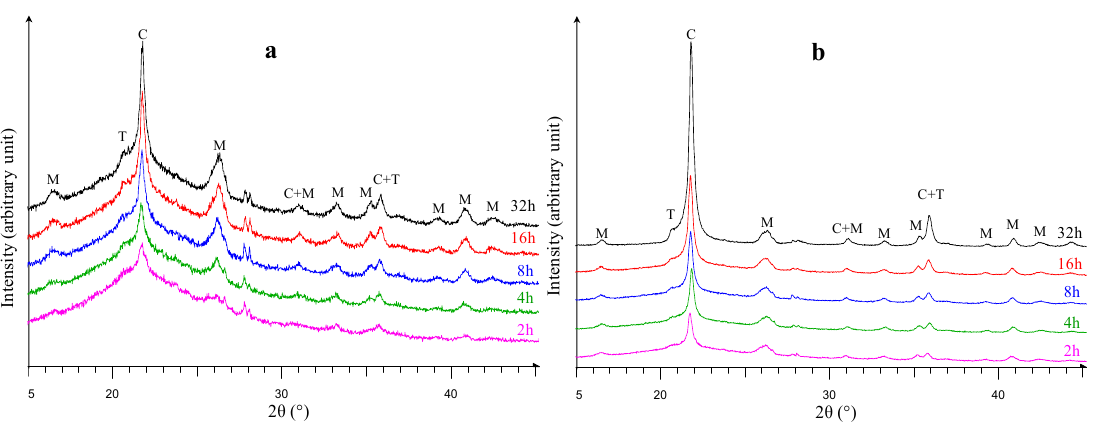
Figure 2. ( a ) XRD patterns of ES-NH treated up to 32 h at 1000; and ( b ) at 1100 °C. C = Cristobalite; M = Mullite; T = Tridymite.